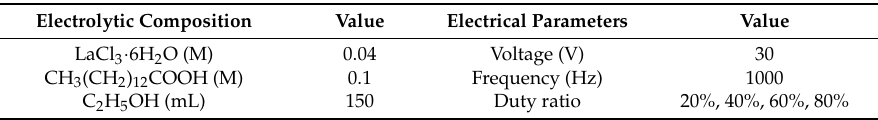
Figure 1. Schematic diagram of ( a ) a pulse electrodeposition setup and ( b ) waveforms of the pulse current applied in the experiments. Table 1. Electrolytic and electrical